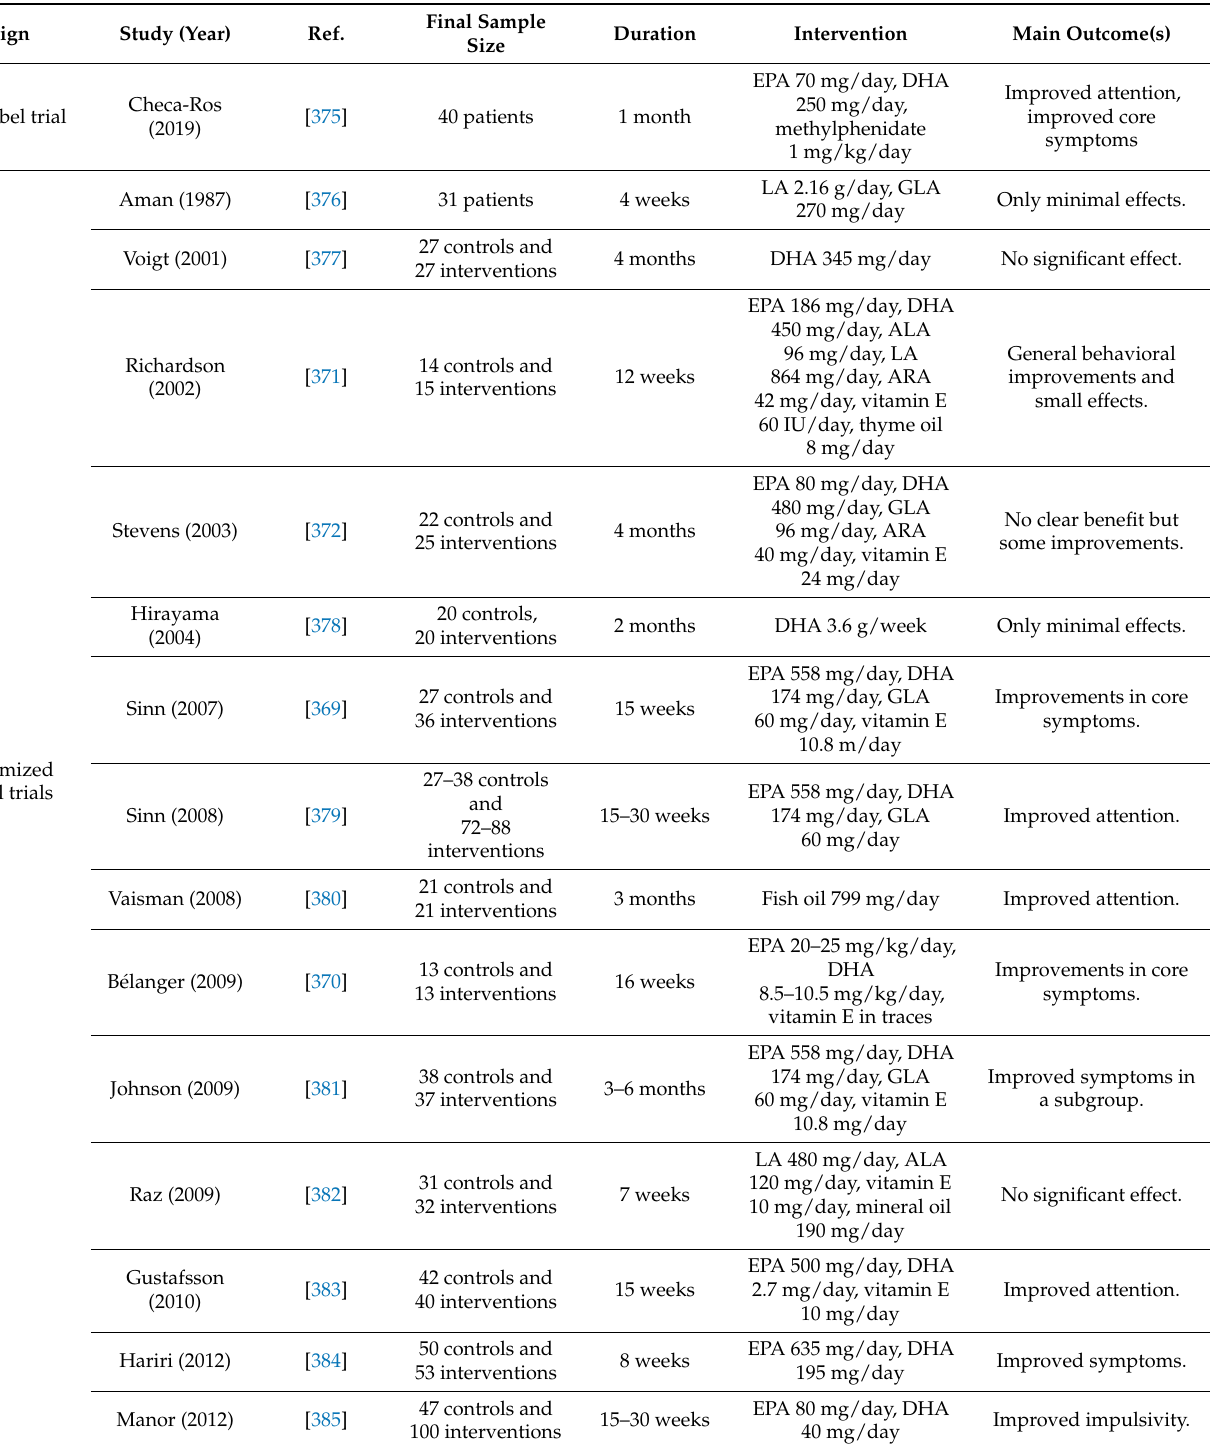
Table 3. Interventional studies using LC PUFAs in patients with ADHD. ALA: α -linolenic acid; ARA: arachidonic acid; DHA: docosahexaenoic acid; EPA: eicosapentaenoic acid; GLA: γ -linolenic acid; LA: linoleic acid; n-3: n-3 PUFAs; n-6: n-6